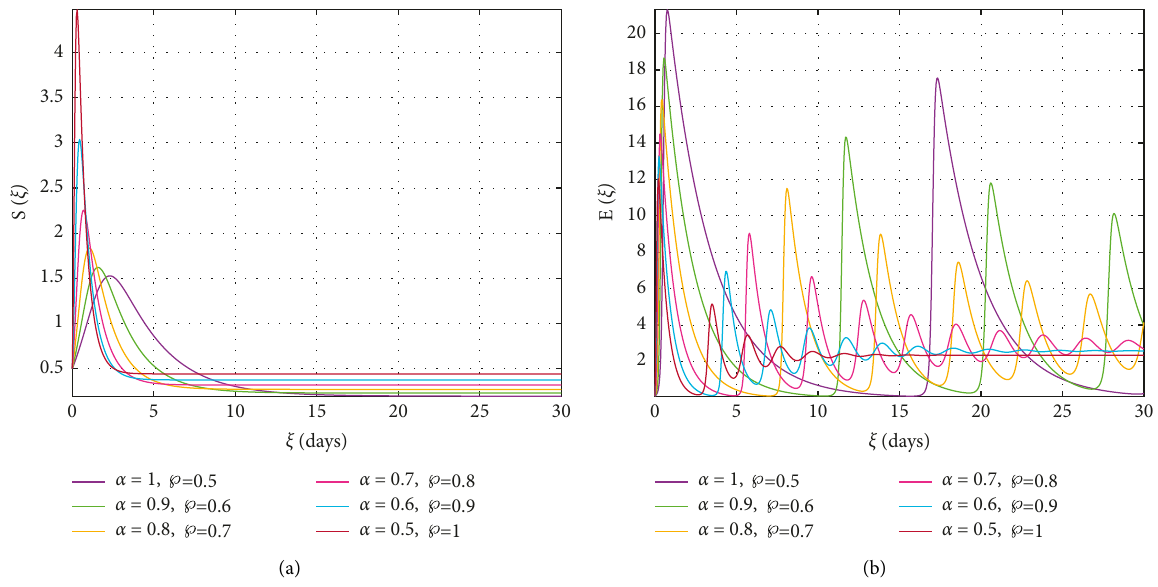
Figure 1: (a) Displays of susceptible individuals S ( ζ ) (b) Displays of exposed individuals E ( ζ ) using a Newton polynomial approach for decreasing fractional-order α and increasing fractal-dimension ℘ .